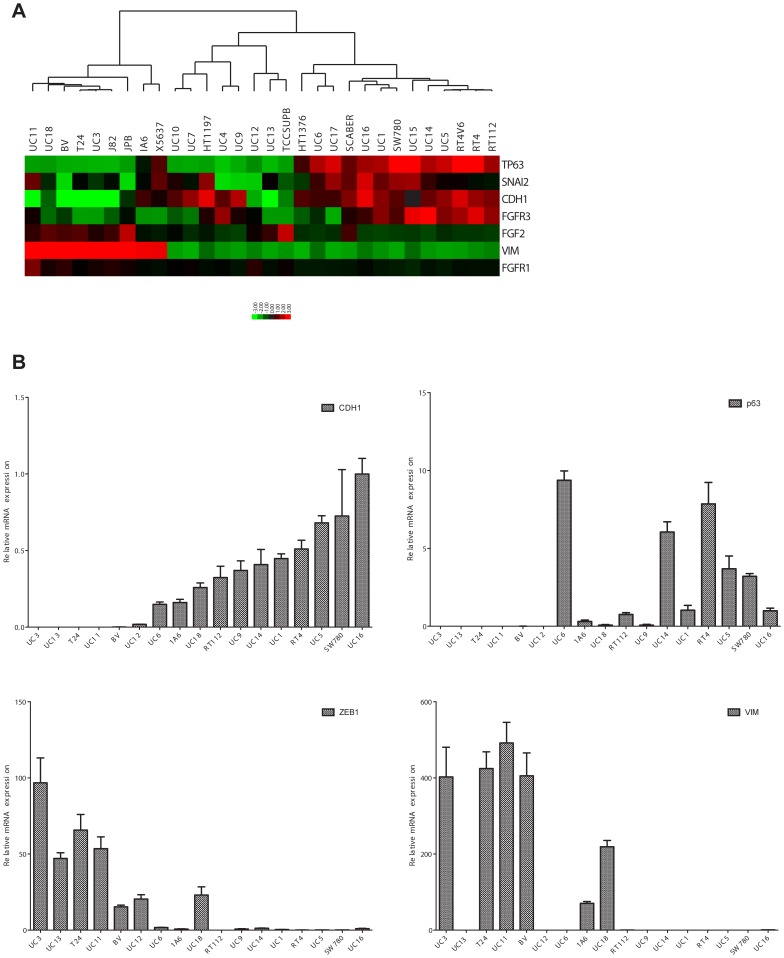
Expression of FGFR1, FGFR3, and bFGF in distinct subsets of human BC cell lines.A. Correlation of FGFR1 and FGFR3 with canonical EMT markers. mRNA levels were measured using whole genome mRNA expression profiling (Illumina platform). The heat map depicts the expression of FGFR1, FGFR3, FGF2 (bFGF), p63 (TP63), E-cadherin (CDH1), Slug (SNAI2), and vimentin. B. Quantitative analysis of EMT marker expression. Relative levels of the “epithelial” markers E-cadherin (CDH1) and p63, and the “mesenchymal’ markers ZEB1 and vimentin were measured by quantitative real-time RT-PCR.